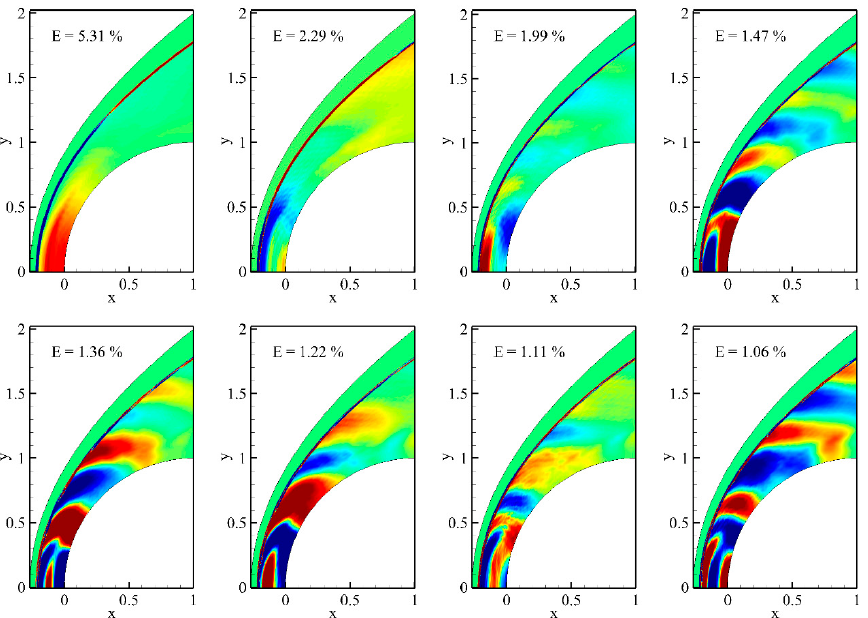
Figure 23. Spatial coherent structure of the flow field with POD analysis for with the Dryer reaction mechanism for 400 × 600 grid resolution (E represents normalized eigen value). POD color scale is the same as Figure 19.